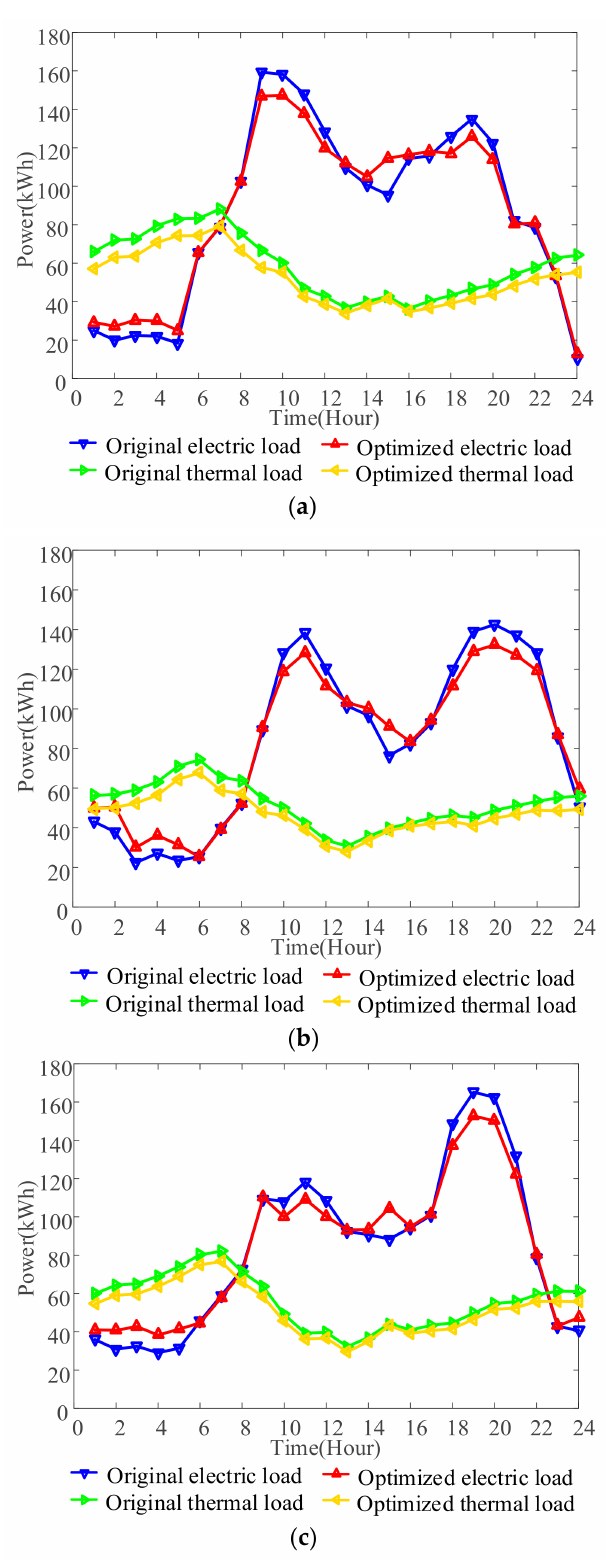
Figure 6. Energy Consumption of Users. ( a ) User1. ( b ) User2. ( c )